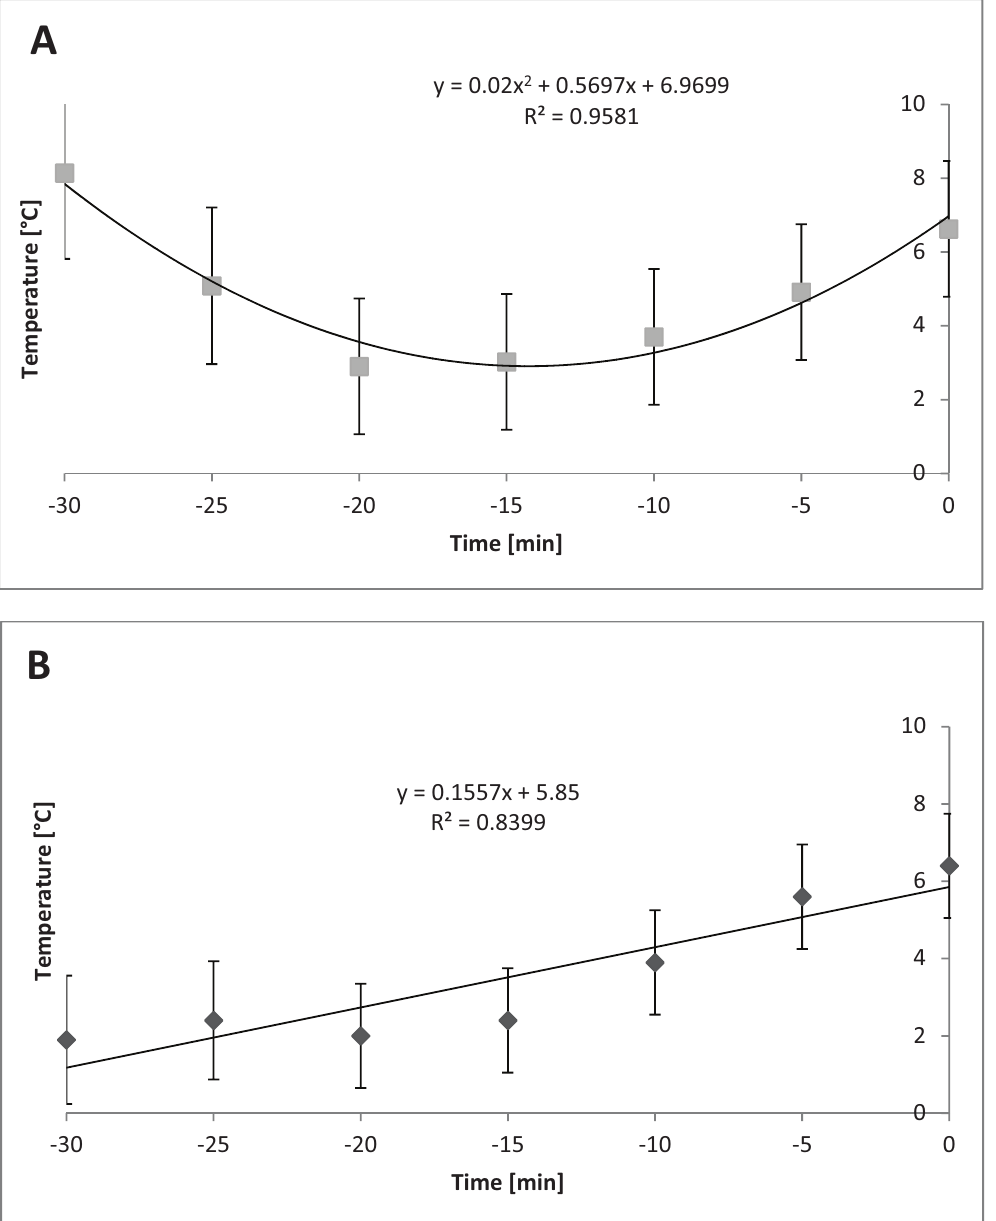
Figure 7. Temperature in cold weather in different compartments of trailer when different levels of bedding are used (n = 33 trailers). ( A ) Quadratic change in temperature in top rear compartment over time when using 1.2 m 3 of bedding during cold ( P = 0.02, SEb < 0.01). ( B ) Linear change in temperature in top front compartment when using 2.4 m 3 of bedding during cold ( P < 0.01, SEb = 0.18).